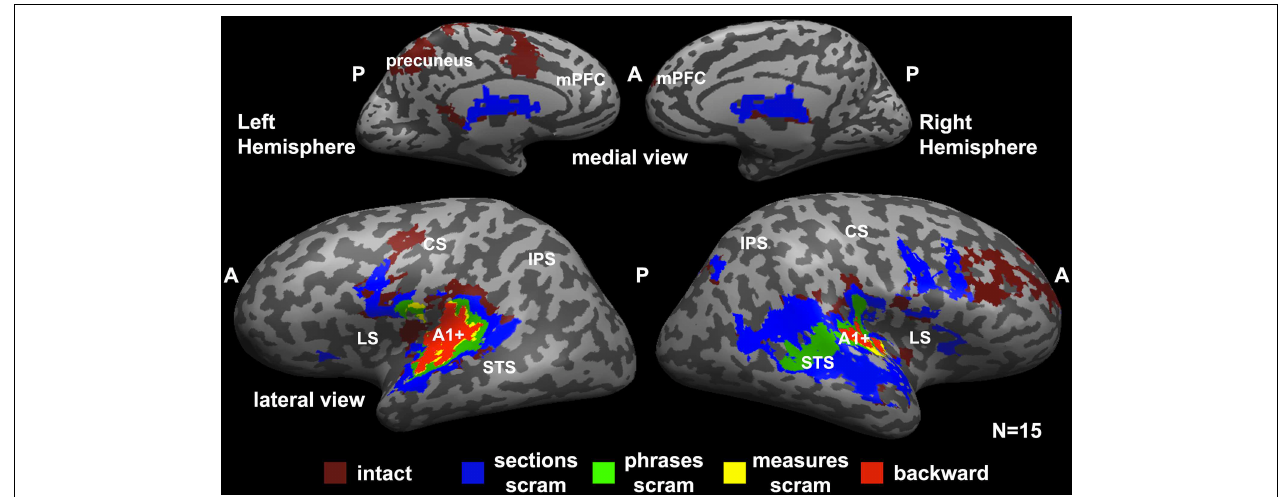
FIGURE 2 | Hierarchical organization of processing timescales (temporal receptive windows, TRWs). Each voxel is colored according to the level of coherent temporal structure that was required to produce significant response reliability (inter-SC) in that voxel across all participants. Red (“backward”), voxels that responded reliably to all stimuli (including the backward stimulus). Yellow (“measures scram”), voxels that responded reliably to all stimuli except the backward stimulus. Green (“phrases scram”),